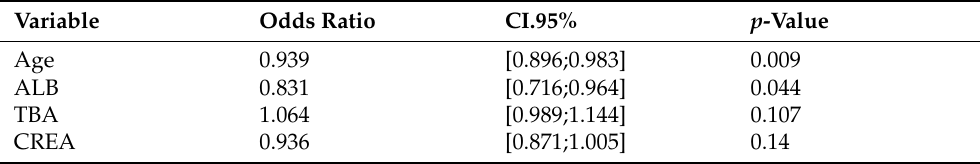
Table 3. Multivariate logistic regression analysis of the clinical characteristics.